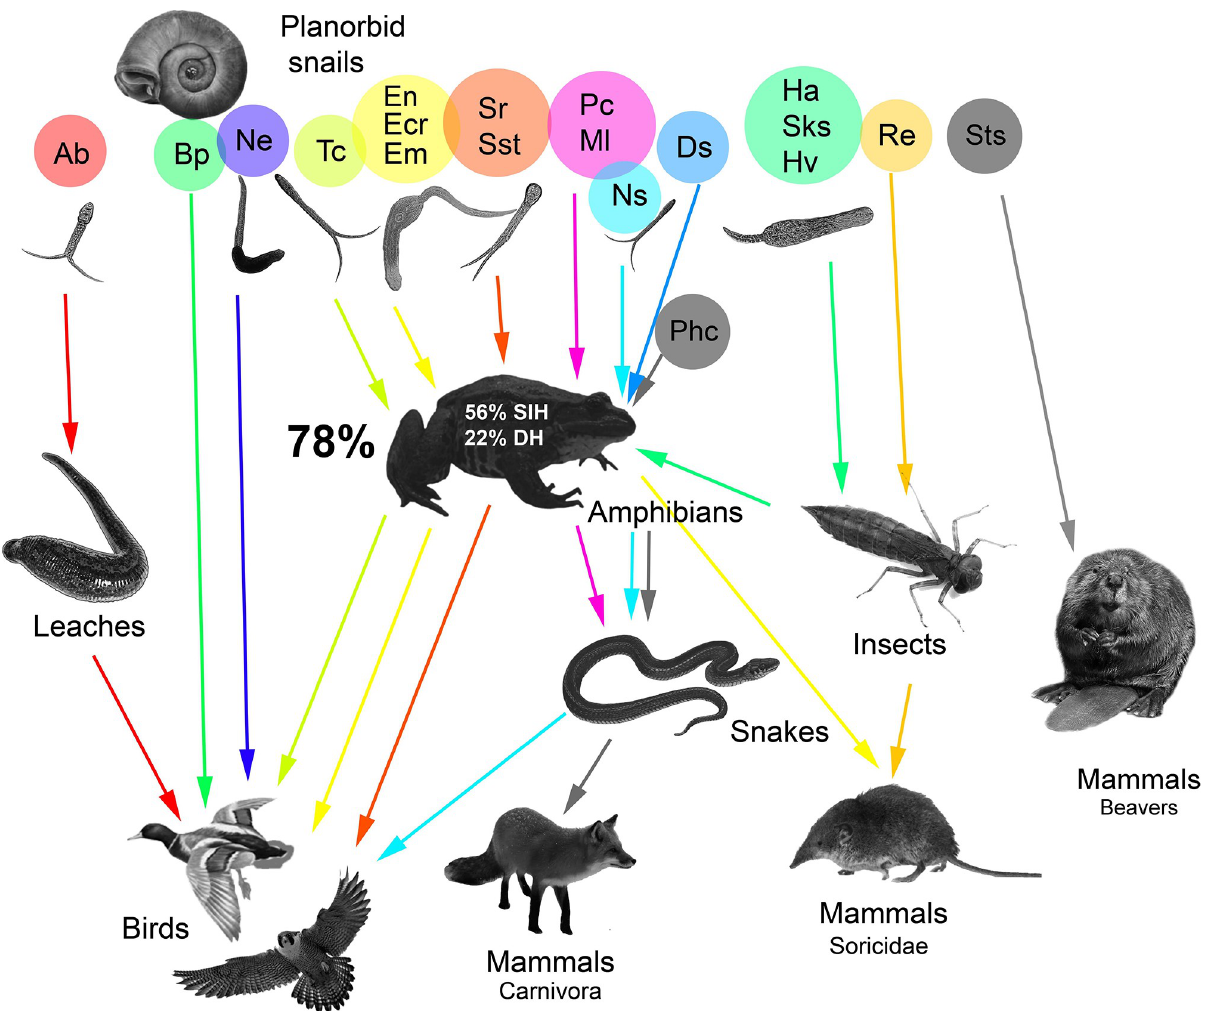
Fig 4. Life cycles of trematode species parasitized in planorbid snails. SIH—second intermediate host; DH—definitive host; Ab—